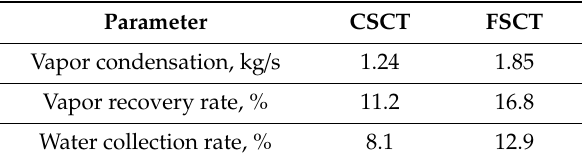
Table 5. Practical engineering parameters of the CSCT and